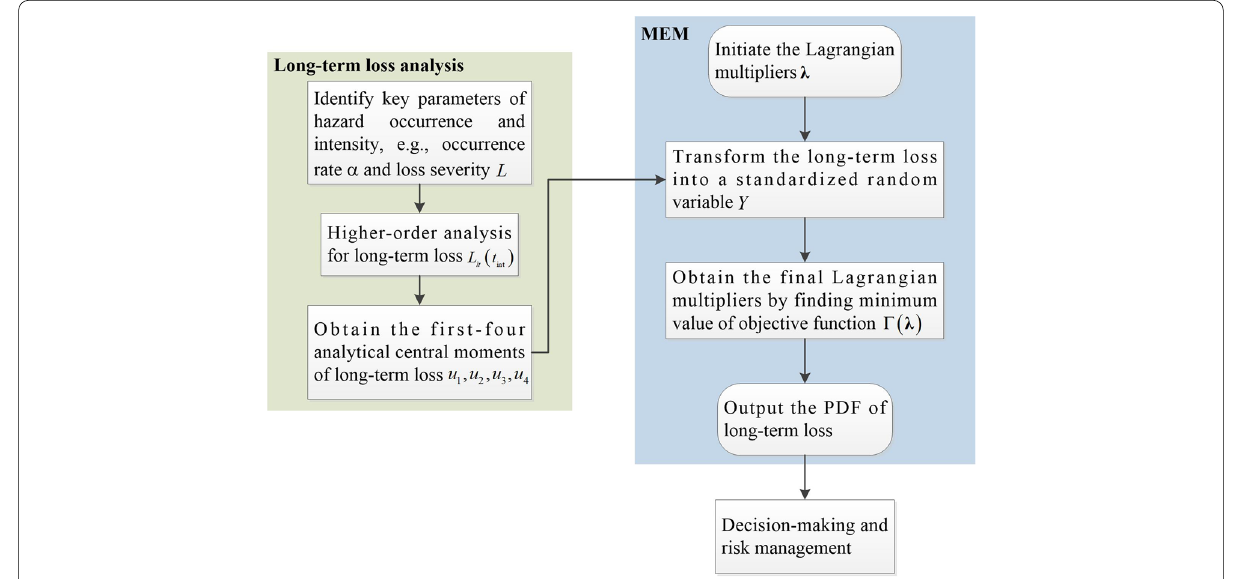
Fig. 2 The flowchart of the proposed